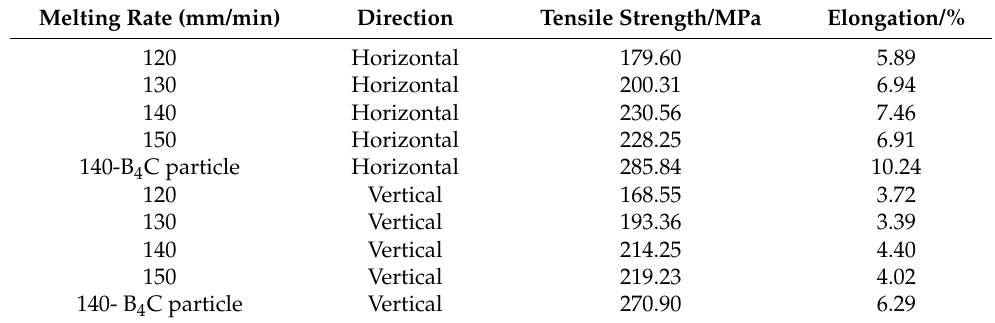
Table 5. Tensile experiment results for aluminum alloys in different orientations of deposition.